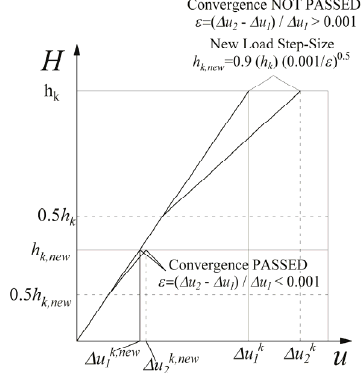
Figure 7. Adaptive step ‐ size control.